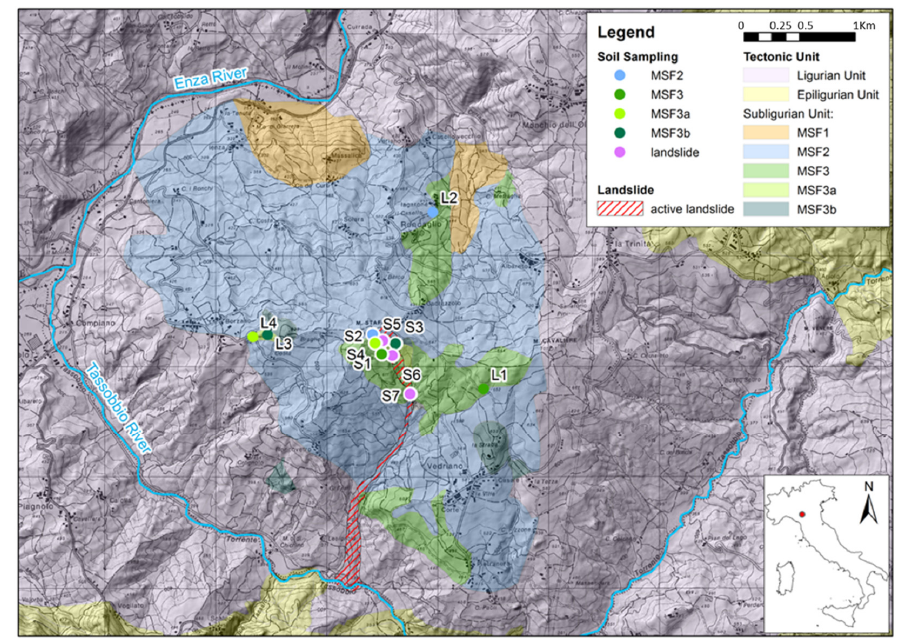
Figure 2. Schematic map of the geological unit (Subligurian and Ligurian units) outcropping in the Vedriano landslide area along with the locations in which soil samples for further leaching and mineralogical tests were collected (in the vicinity of the landslide: S1 to S7; outcrops located 2 km far from the landslide:L1 to L4).